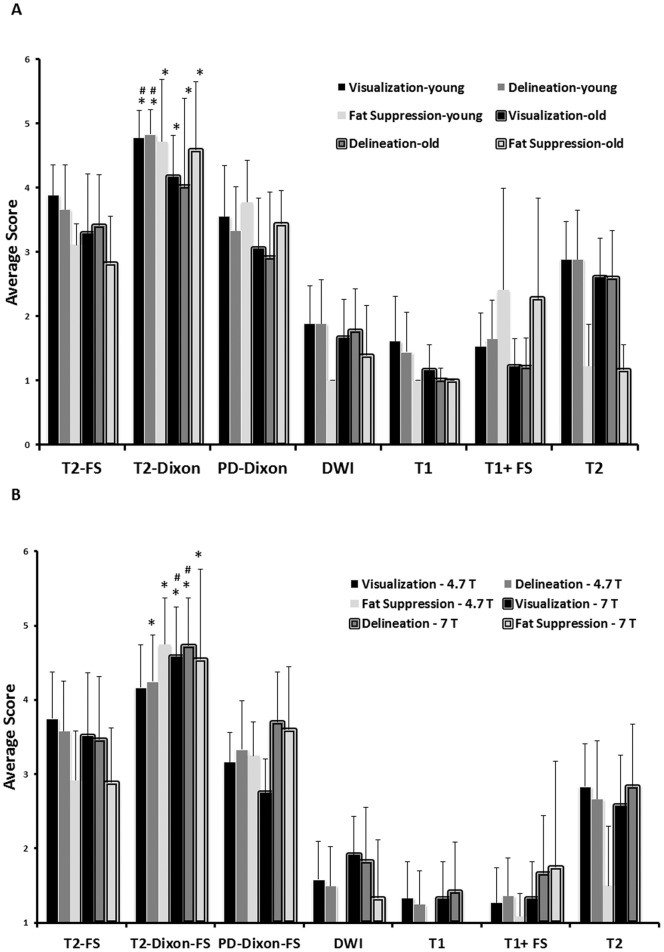
Prostate visualization, prostate border delineation, and fat suppression of young and old SCID and nude mice ranked significantly higher on T2-Dixon “water only” overall and generally better than T2 FS images using either 4.7 T or 7T scanners.A) 7T magnet, young vs old mice (*, P<0.01, T2-Dixon vs T2 FS; #, P<0.001, T2-Dixon “water only” young vs old); B) 4.7 T vs 7T (*, P<0.01, T2-Dixon vs T2 FS; #, P<.05, T2-Dixon “water only” 4.7T vs 7T). Reader 1 data presented.